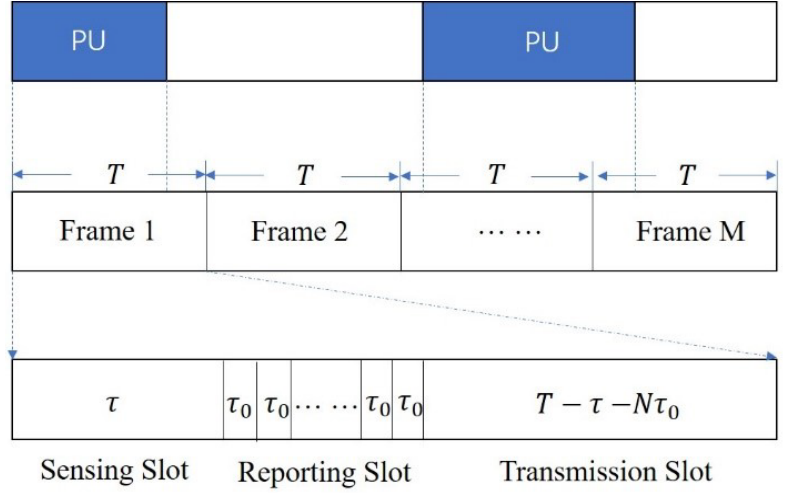
Figure 2. Architecture of a frame in CRNs.